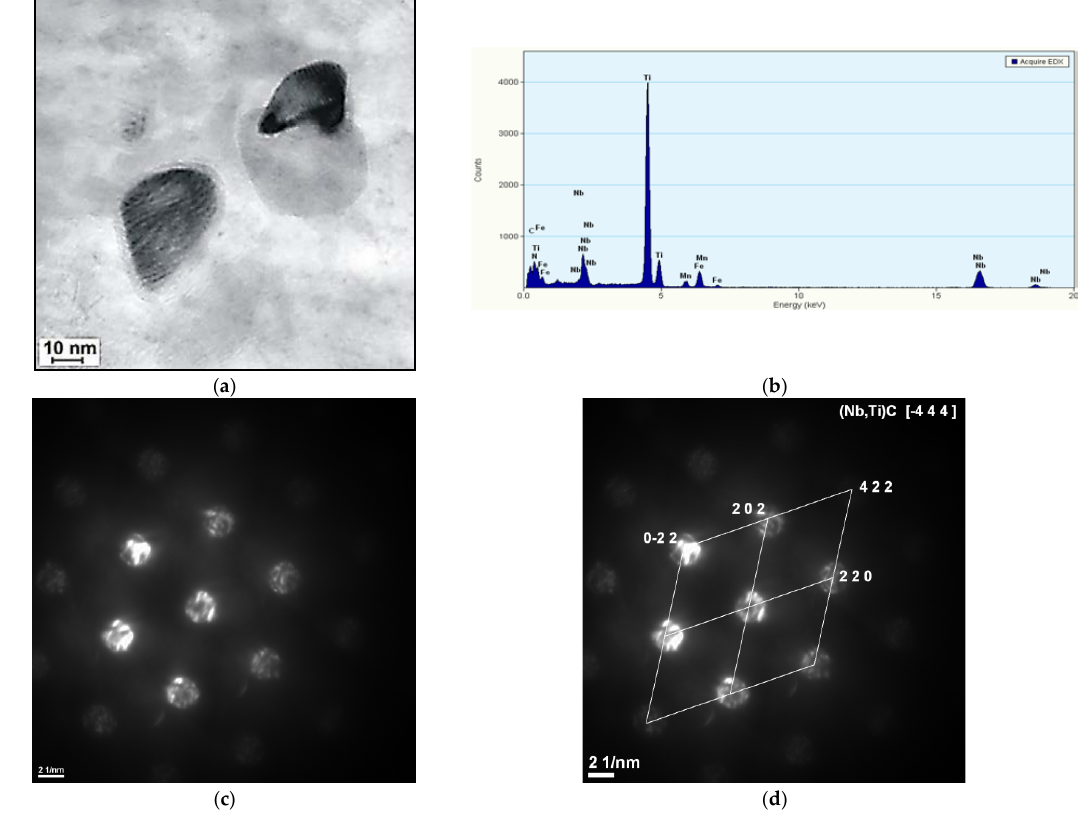
Figure 4. Dispersive precipitation of carbides (Ti,Nb)C in S700MC steel limiting the growth of recrystallized austenite grains. ( a ) dispersive precipitation of carbides (Ti,Nb)C, ( b ) EDX spectrum, ( c ) diffraction pattern, ( d ) diffraction pattern solution.